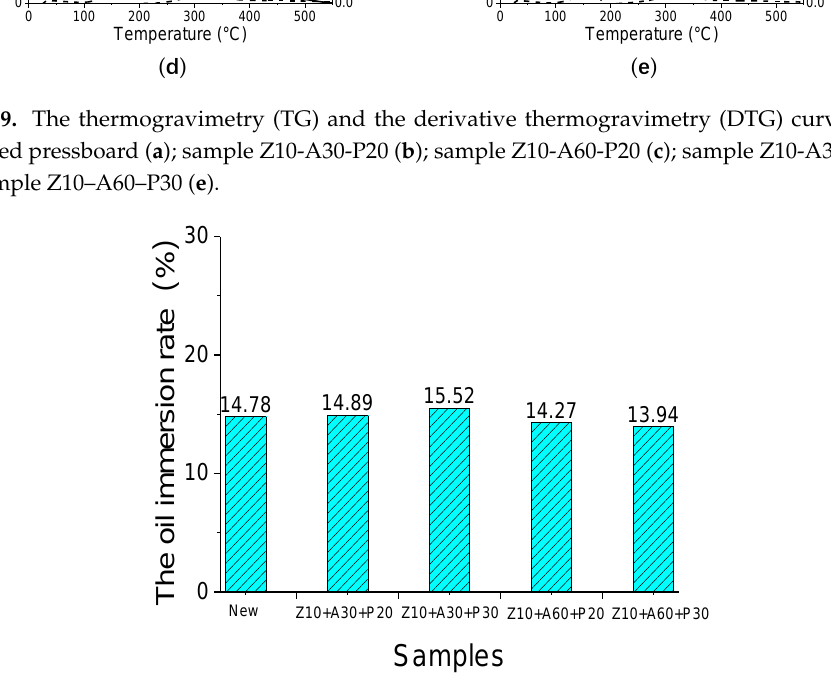
Figure 11. The dielectric constant increased in the low frequency range, while the dielectric loss increased at the same time. This was termed a low frequency dispersion (LFD) by Jonscher [37]. However, the dielectric constant of the coated pressboard was much higher than that of the untreated insulating pressboard in the low frequency region, and there were 1–2 loss peaks in Figure 11 of the dielectric loss tangent. The polarization reached equilibrium by overcoming a certain potential energy, so it needed to absorb a certain amount of energy, which is the reason for the dielectric loss peak formation. The establishment of polarization takes a certain amount of time, and the relaxation time constant of polarization can be calculated by the Debye model [38].